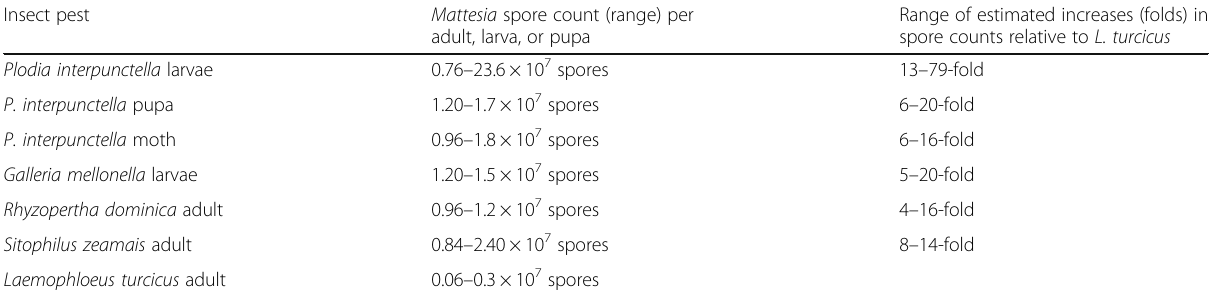
Table 2 Range of spore counts and their estimated increases (folds) per Mattesia -infected host relative to those of Laemophloeus turcicus